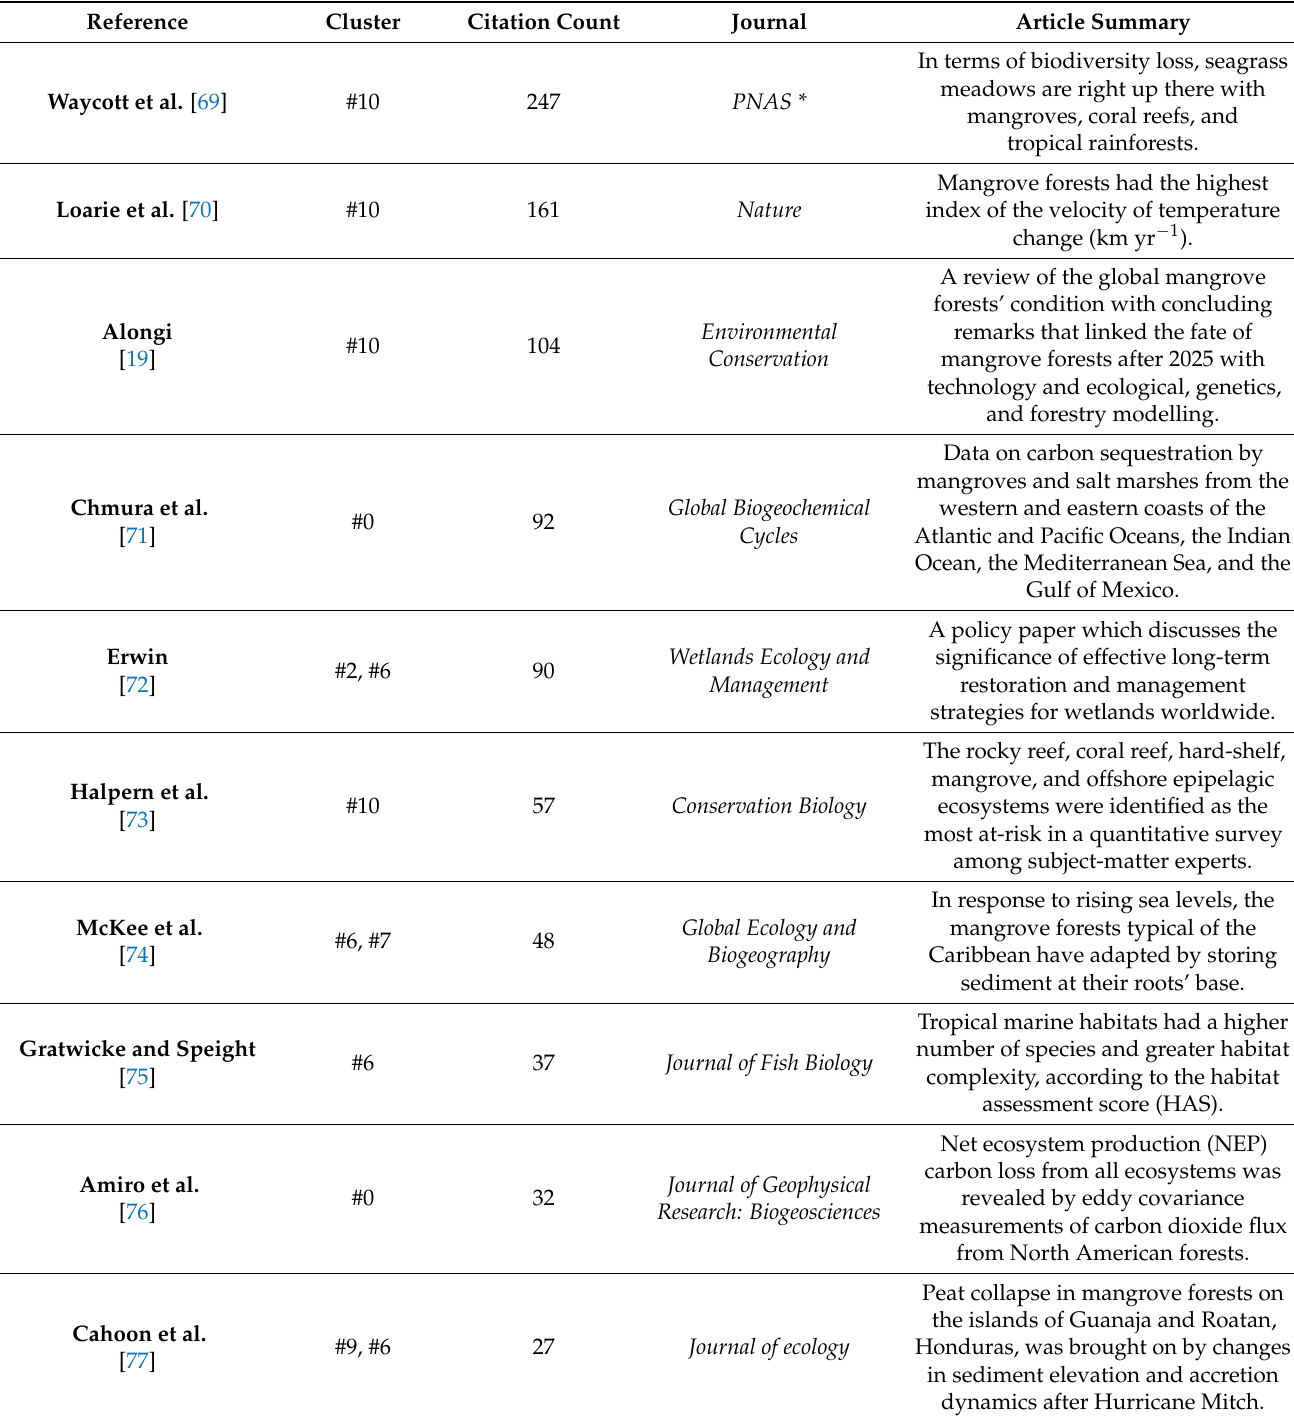
Table 5. Co-citation analysis of major citing articles pertinent to mangrove and climate